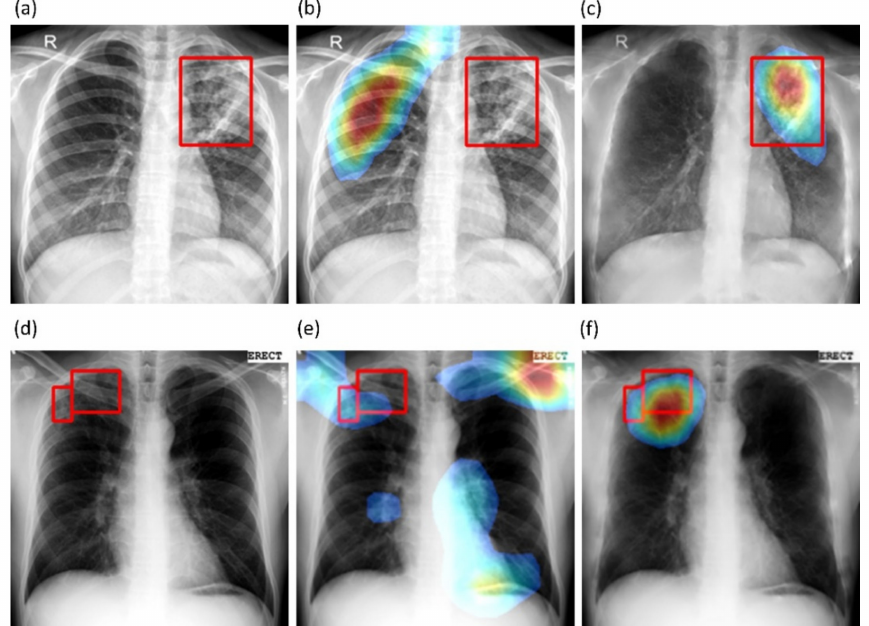
Figure 10. CRM-based TB-consistent ROI localization achieved by the best-performing baseline and bone-suppressed model, respectively, using a sample CXR from the Shenzhen and Montgomery TB CXR collection. ( a ) a CXR instance from the Shenzhen TB CXR collection with expert ground